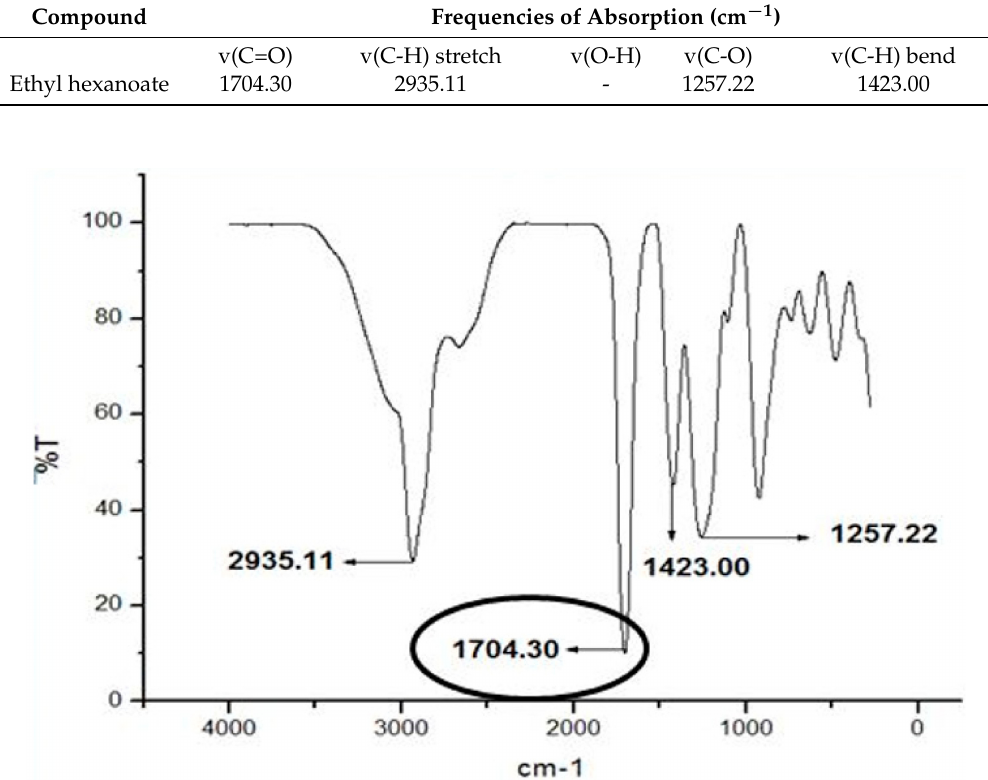
Figure 9. IR spectrum of ethyl hexanoate. Spectrum indicating the presence of ester is shown in circle area.